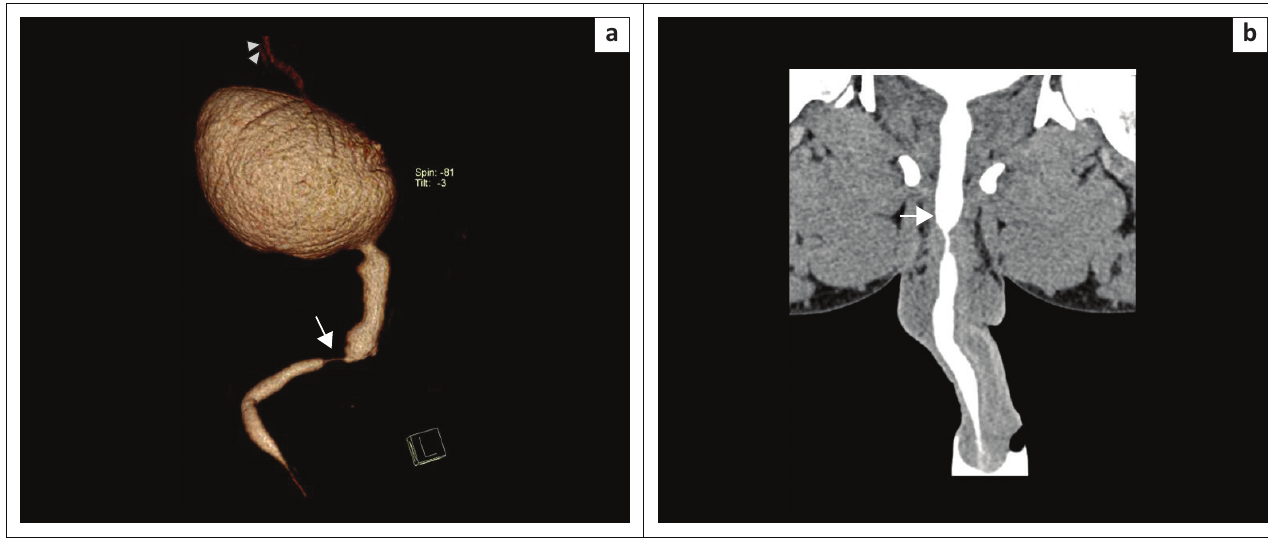
FIG URE 2: (a) Volume rendering technique and (b) curved multiplanar reformatted image. Images demonstrate a tight penobulbar stricture (arrow), with a dilated posterior urethra. The opacified distal ureters (arrowheads) are visible as the patient was administered intravenous contrast, and they should not be interpreted as vesico- ureteric reflux (VUR). This patient could not be catheterised at retrograde urethrography because of the tight